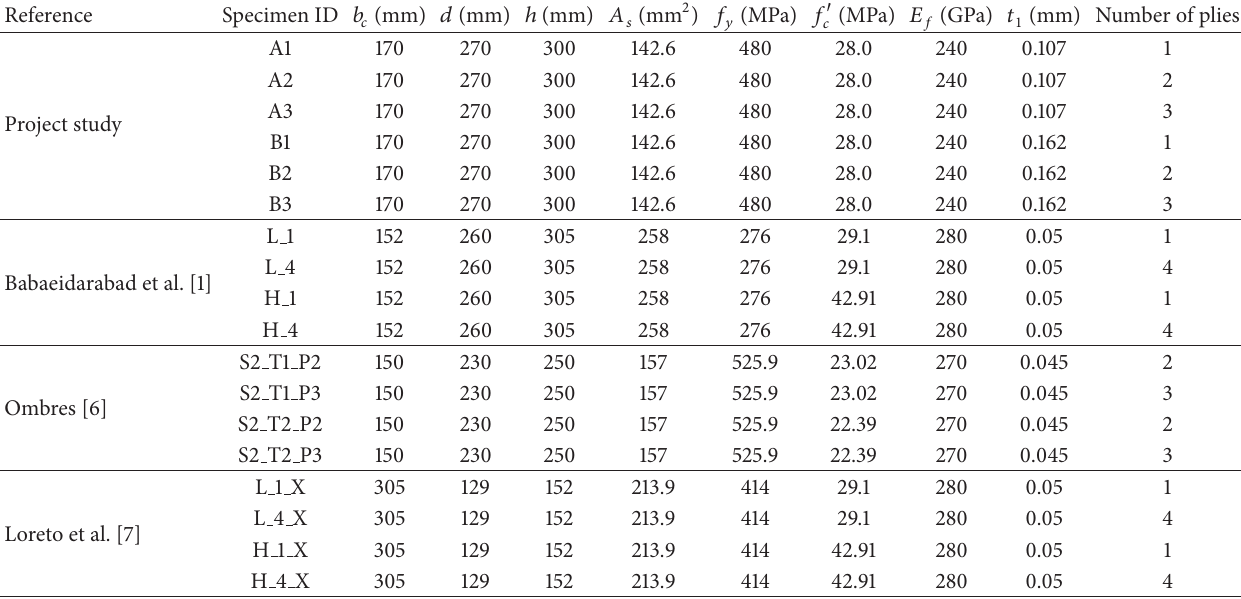
Table 7: Database for RC beams strengthened with FRCM